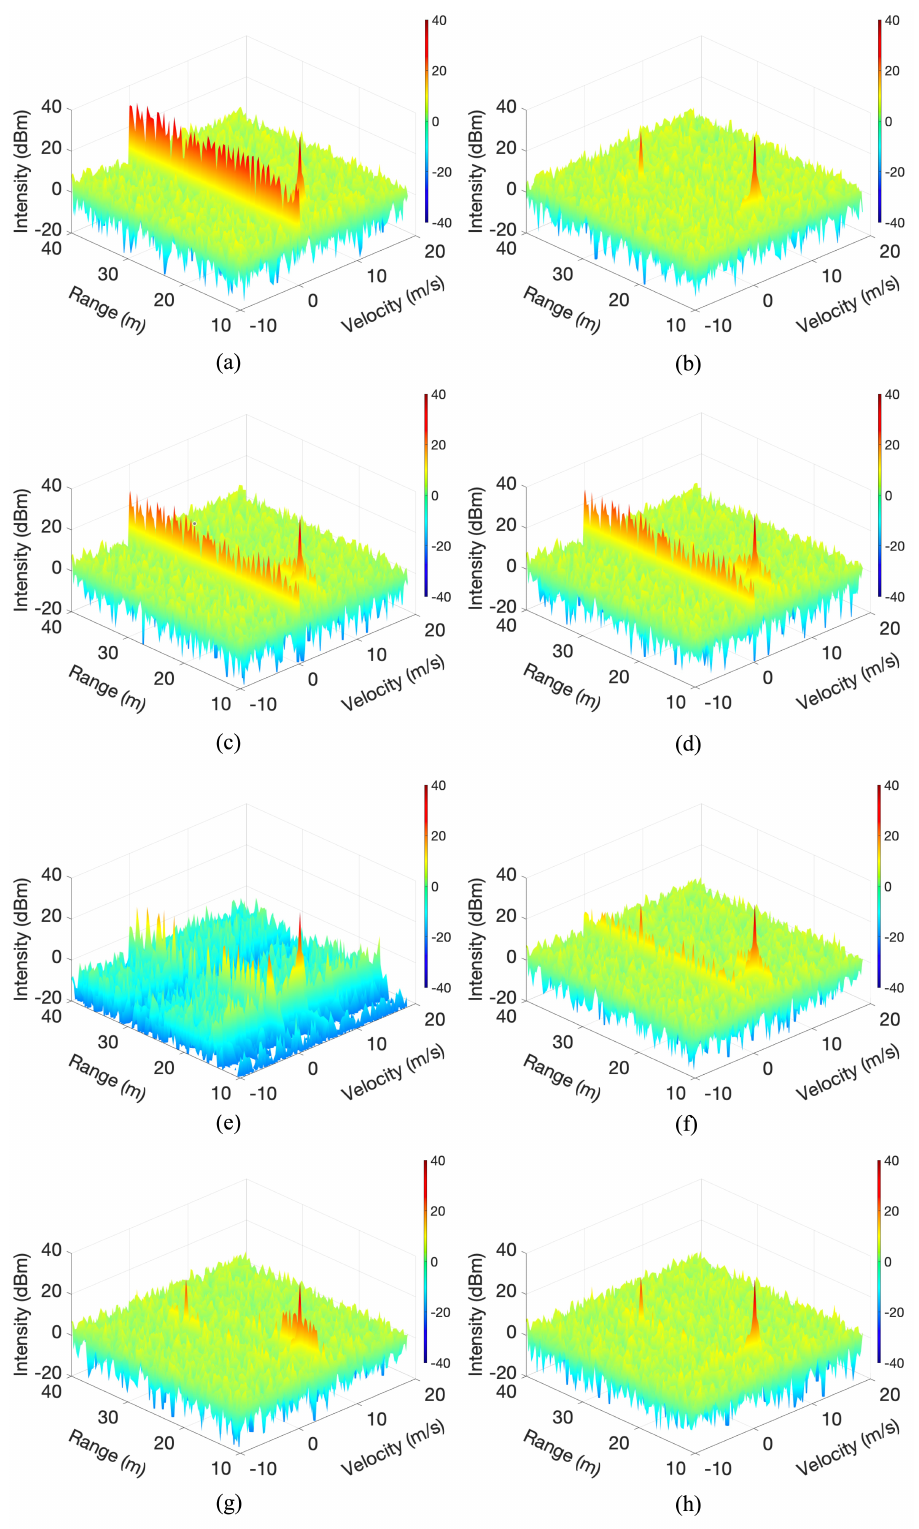
Figure 7. Comparisons on stationary interference simulations. ( a ) Original image; ( b ) Interference- free image; ( c ) Lee et al. [19]; ( d ) Lee et al. [19] + Proposed interference detection; ( e ) Uysal [23]; ( f ) Uysal [23] + Proposed interference detection; ( g ) Brooker [15]; and ( h ) The proposed